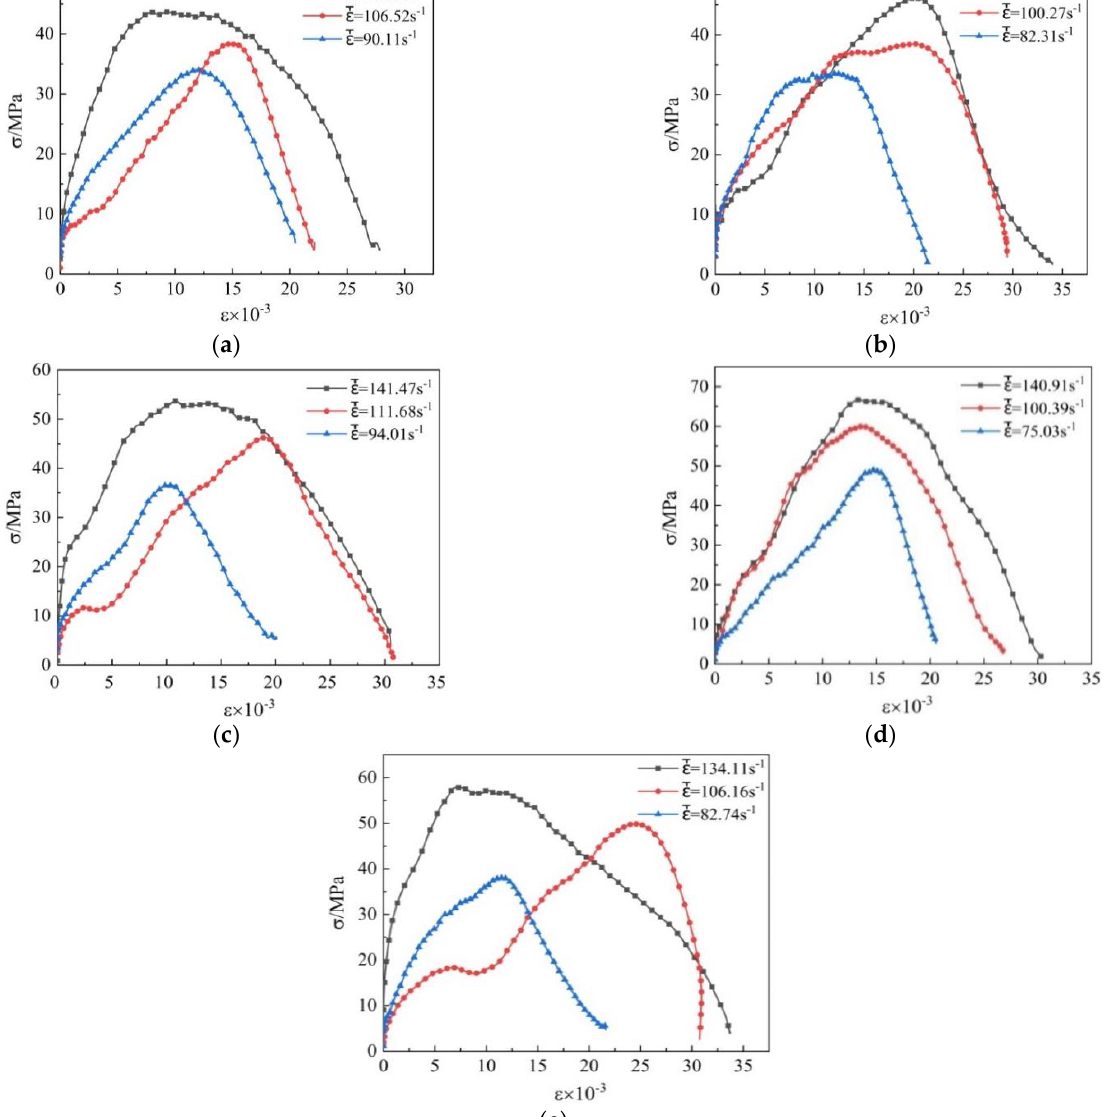
Figure 5. Stress-strain curve of SCM with five fiber contents: ( a ) G0; ( b ) G0.25; ( c ) G0.5; ( d ) G0.75; ( e ) G1.